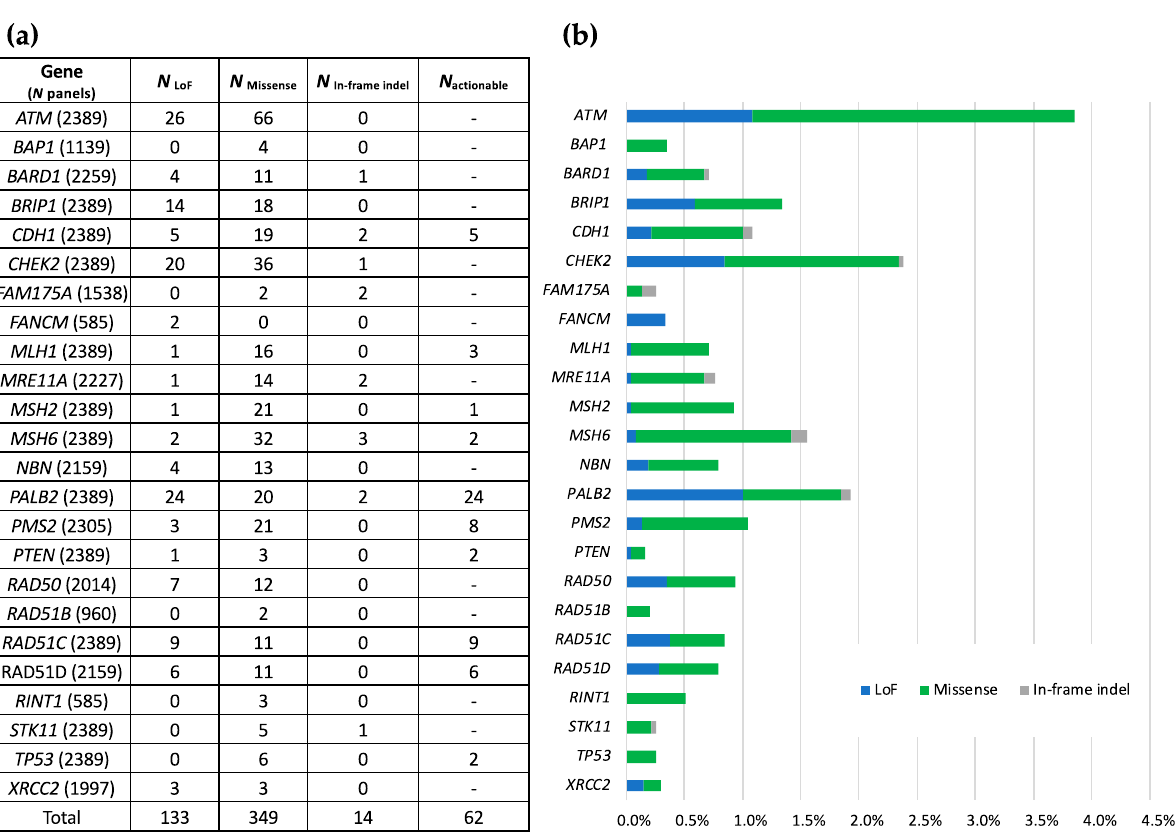
Figure 3. Distribution of eligible variants identified in the prospective index cases, per gene and per variant type. ( a ) Number of loss of function variants ( N LoF ), missense variants ( N missense ), in-frame indels ( N indel ) and actionable variant ( N actionable ) per gene. N panels : number of analysed panels containing the gene. ( b ) Weighted distribution of variants per gene (number of detected variants/ N panels ).